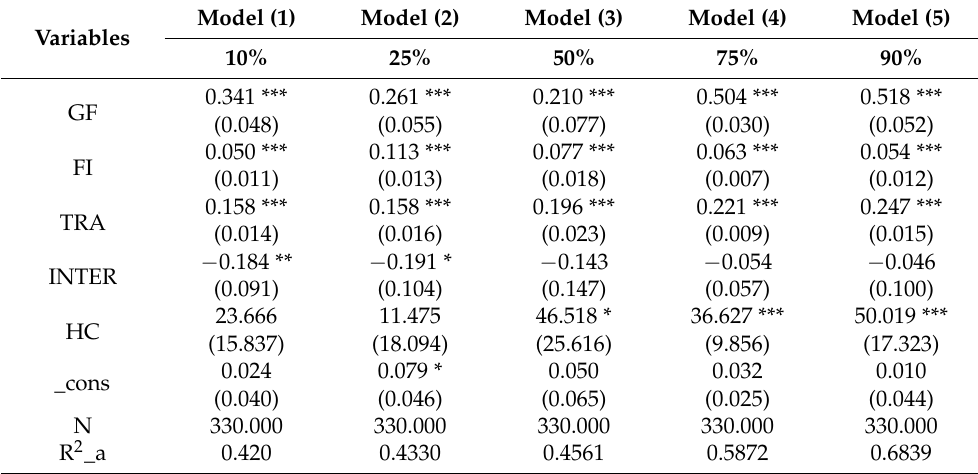
Table 11. Panel quantile regressions of green finance on quality economic